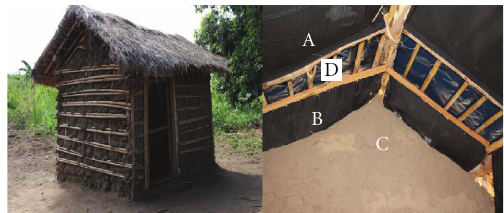
Figure 2: Mud hut at Lupiro village with fixed (A) cotton-cloth roof treated with fungal conidia, (B) ba ffl es to reduce exit of mosquitoes, (C) mud walls either treated with fungal conidia or untreated for resting mosquitoes, and (D) open eave to allow host seeking mosquitoes to enter inside the